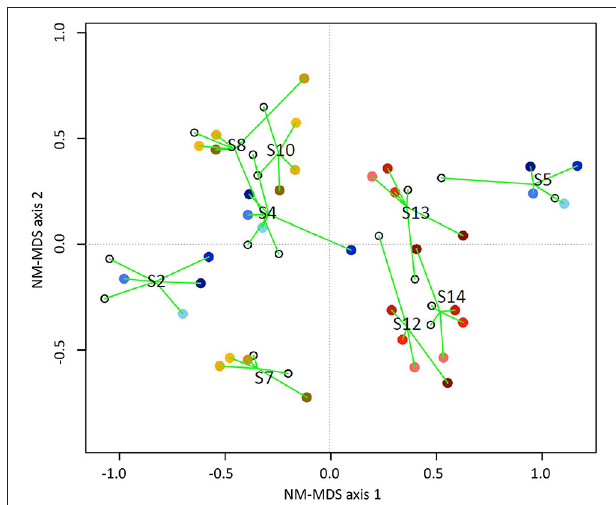
FIGURE 7 | NM-MDS ordination showing a host-specific grouping of butyrate communities based on combined but and buk gene datasets for all participants in experimental variants: NBR (blue), HBR (red), HAmb (yellow). The time spent in experiment is designated by darker colors. Stress buk + but = 0.18. Only OTUs represented by at least 50 sequences were used in analyses. The numbers designate sample groupings according to